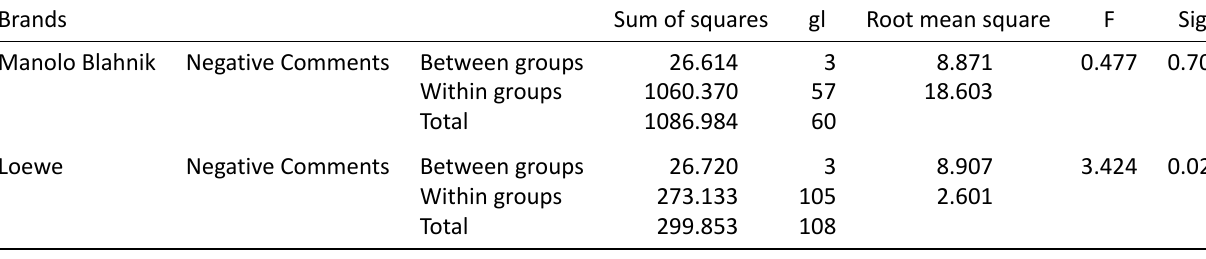
Table 9. ANOVA statistic of negative comments as a function of brand content.